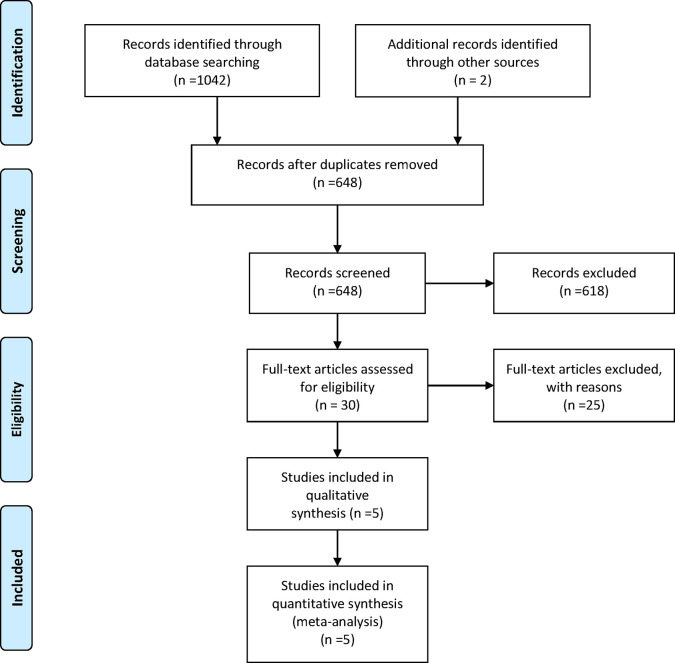
Study Flow Diagram.